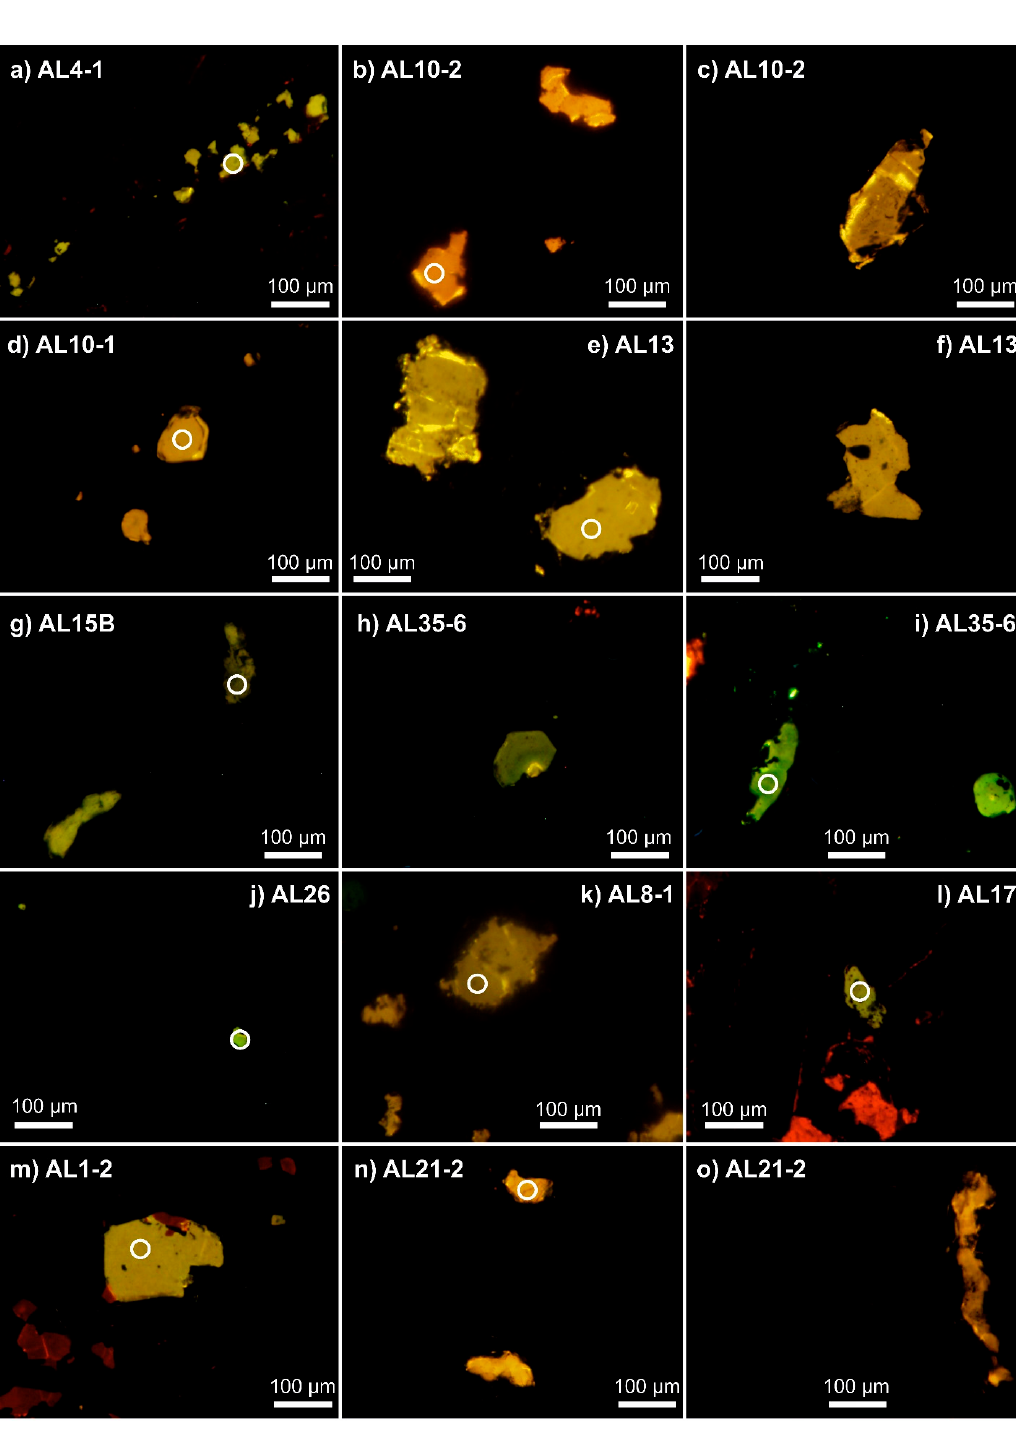
Figure 6. Cathodoluminescence images collected from apatite crystals in BIFs ( a – i ), metachert ( j ), metacarbonate rocks ( k – l ), and mafic dykes ( m–o ). Crystal with intensive red luminescence surrounding apatite AL35-6 ( h – i ), AL17 ( l ), and AL1-2 ( m ) is the carbonate mineral. White circles indicate analytical spots in which the cathodoluminescence (CL) spectra (Figure 7 and Figure S2) were collected. A broad emission band located in the yellow-green part of the CL spectrum with a peak maximum at 584–593 nm indicates that Mn 2+ is the main luminescence activator in Isua apatite